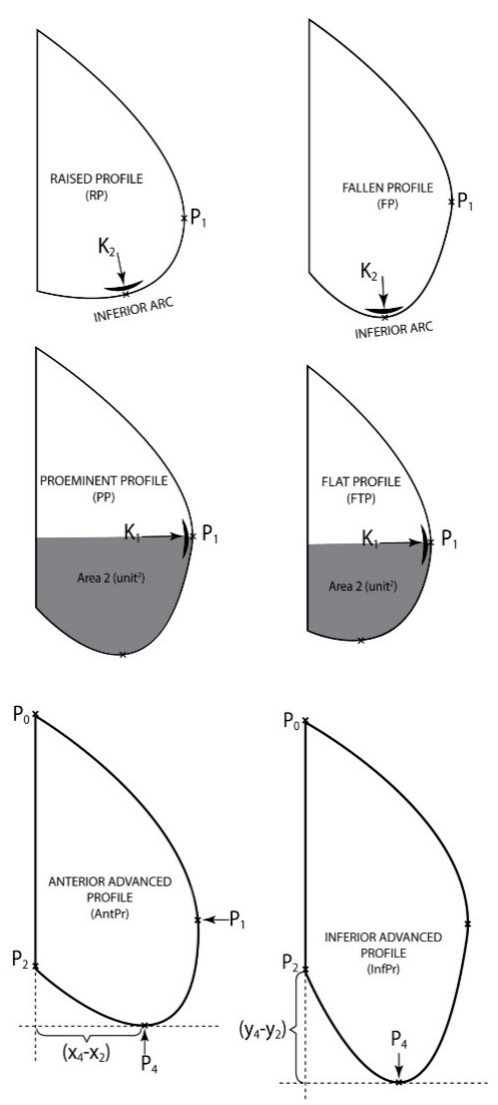
Figure 4. Models of abdominal profiles A.